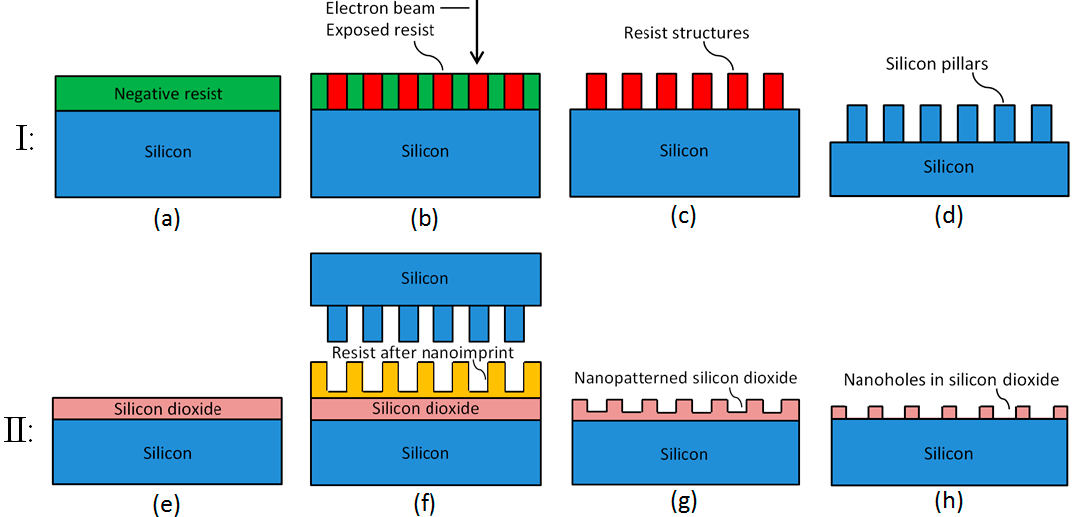
Figure 1. Schematic illustration of the SiO 2 nanohole fabrication steps: Fabrication of Si stamp (Section I): ( a ) Spin coating of negative resist on Si wafer. ( b ) Electron-beam exposure using negative resist. ( c ) Development to produce resist pillars. ( d ) Si etch by deep reactive-ion etching (DRIE) to produce Si pillars; Fabrication of SiO 2 nanoholes (Section II): ( e ) Dry oxidation of Si to produce a SiO 2 layer. ( f ) Spin coating of resist and hot embossing using the Si stamp. ( g ) Removal of residual resist by reactive-ion etching (RIE) followed by SiO 2 etch by RIE for nano-patterning and subsequent removal of resist. ( h ) SiO 2 wet etching to expose the Si surface in nanoholes.